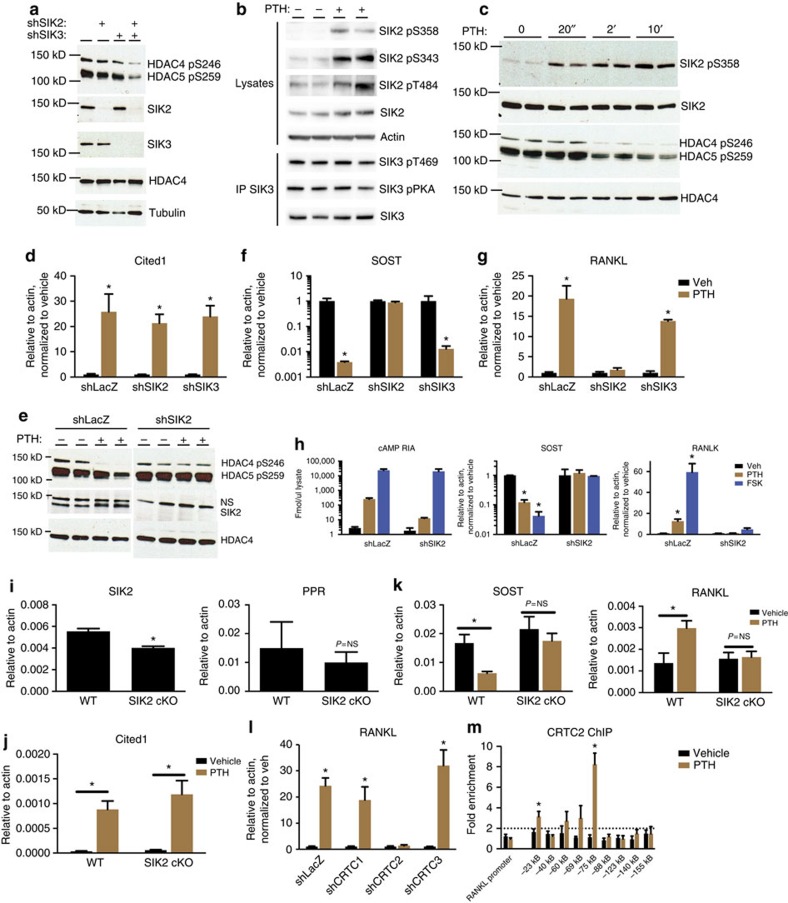
SIK2 activity is regulated by PTH signaling.(a) Ocy454 cells were infected with shRNA-expressing lentiviruses, followed by immunoblotting. (b) Ocy454 cells were treated with vehicle or PTH (50 nM, 30′), followed by immunoblotting. In the bottom panels, SIK3 immunoprecipitation was performed followed by immunoblotting. (c) Ocy454 cells were treated with PTH (50 nM), followed by immunoblotting. (d) Ocy454 cells infected with either control, shSIK2 or shSIK3-expressing lentiviruses were treated with PTH (1 nM) for 4 h. RNA was isolated and CITED1 transcript abundance measured. * indicates P<0.05 comparing vehicle and PTH for each cell line. (e) Control and shSIK2 cells were treated with PTH (50 nM, 30′) and then analysed as in (b). (f,g) Control, shSIK2 and shSIK3 cells were treated as in (d), and SOST and RANKL transcript abundance measured. * indicates P<0.05 comparing vehicle and PTH. (h) Left, control and shSIK2 cells were treated with vehicle, PTH (25 nM) or forskolin (FSK, 5 μg ml−1) for 30 min followed by cAMP radioimmunoassay. Middle/right, cells were treated with PTH (2.5 nM) or forskolin (500 ng ml−1) for 4 h, gene expression was analysed. (i) RNA from femurae of 5 week old male WT (SIK2 f/f) or SIK2OcyKO (SIK2 f/f;DMP1-Cre) mice (n=3 group−1) was isolated and SIK2 and PTH receptor (PPR) transcripts measured by RT-qPCR. * indicates P<0.001 comparing WT and SIK2 cKO mice. (j,k) Mice as in (i) were treated with a single dose of PTH (1 mg kg−1) and killed 2 h later. Expression of CITED1, SOST and RANKL in femur RNA was determined by RT-qPCR. * indicates P<0.05 comparing vehicle and PTH. (l) Ocy454 cells were infected with shRNA-expressing lentiviruses targeting CRTC1, CRTC2, or CRTC3. Cells were then treated with PTH (1 nM, 4 h) and RANKL transcript abundance was measured. (m) Ocy454 cells were treated with vehicle or PTH (20 nM, 60 min) followed by ChIP for CRTC2. DNA was quantified by qPCR using primers detecting the indicated RANKL regions, and data are expressed as fold enrichment versus control IgG. *indicates P<0.05 comparing vehicle and PTH. The −23 kB and −75 kB enhancers correspond to ‘D2' and ‘D5' enhancers42.